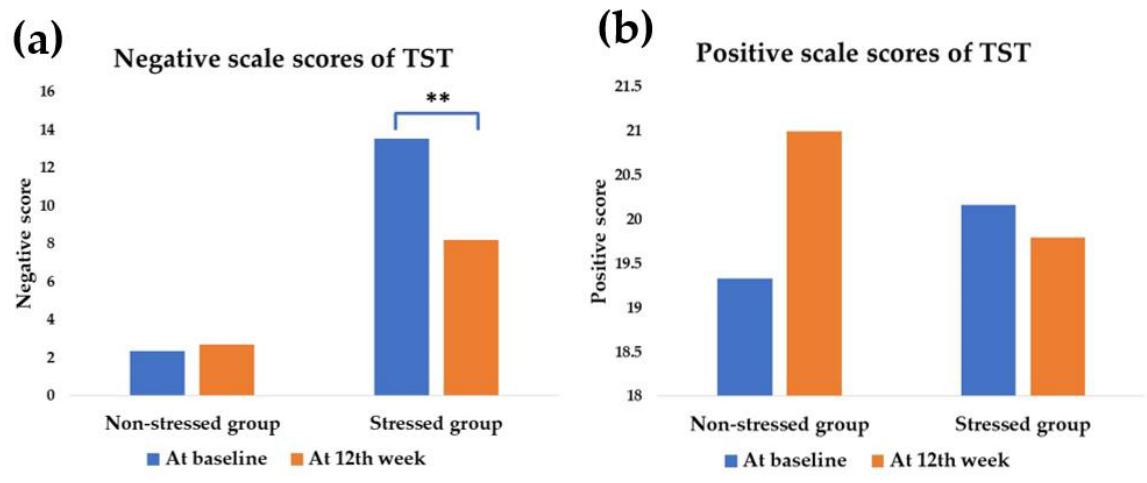
Figure 3. Modulation of mean TST scores according to either negative scale scores or positive scale scores after the synbiotics administration. The blue bar is the scores at the baseline, and the orange bar is the scores at the 12th week of synbiotics administration. ** significant difference ( p less than 0.05). ( a ) The negative scale scores of TST in the stressed group were attenuated at the 12th week ( p = 0.001, power = 0.98). ( b ) The positive scale scores of TST were not significantly changed in both groups ( p < 0.05).